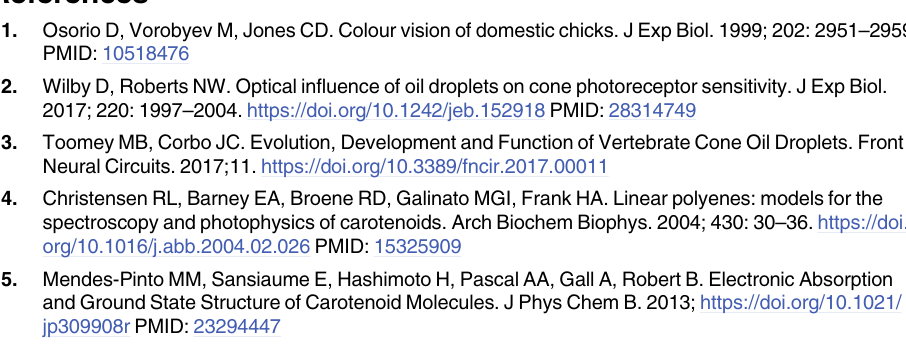
S1 Fig. Typical HPLC trace of carotenoid extract from white leghorn chickens, upon saponification with 0.02 M NaOH. Detection was at 450 nm. 1 –galloxanthin; 2 –astaxanthin; 3 – cis -astaxnthin; 4 –lutein; 5 –zeaxanthin; 6 – ε -carotene. Shorter chain-length apo-caroten- oids are indicated by arrows; additional species eluting in the 40–60 min region are carotenoid esters. S2 Fig. Resonance Raman spectra of P & C droplets at room temperature, excited at 413.1 nm. The ν position of galloxanthin is shown with a dotted line, while additional contributions 1 from shorter-length carotenoids are indicated by an